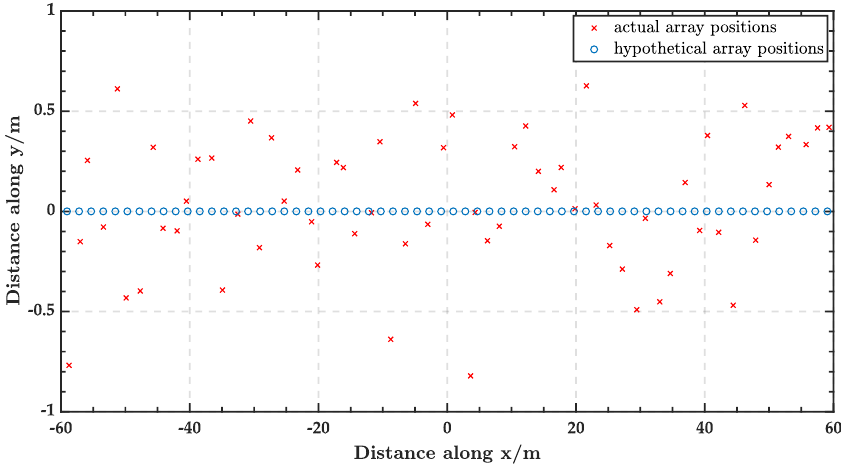
Figure 6. Hypothetical and actual sensor positions of a ULA with 64 elements.